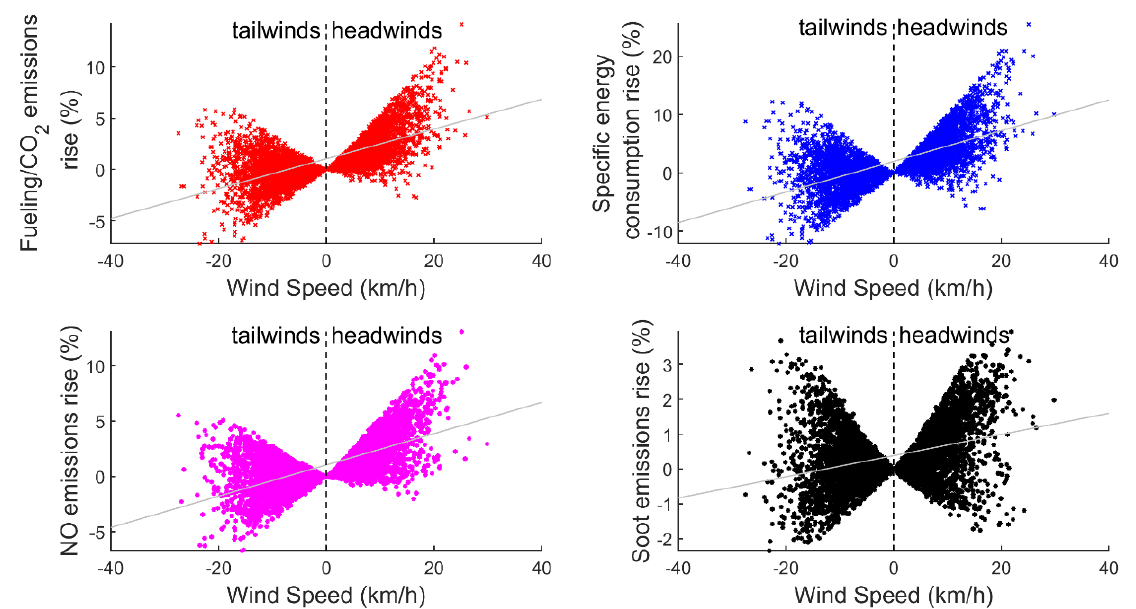
Figure 7. Percentage increase in consumption and emissions vs. wind speed for the extra-high phase of the WLTC.